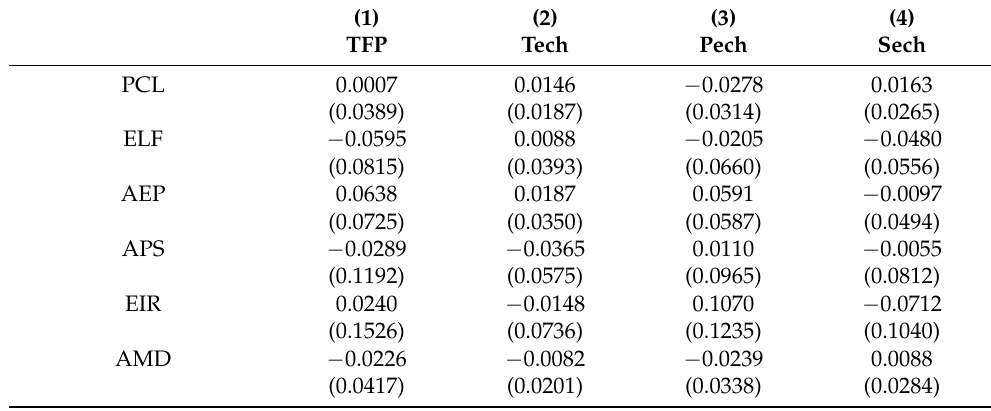
Table 6. Factors Influencing the Production Efficiency of Japonica Rice and Its Decomposition